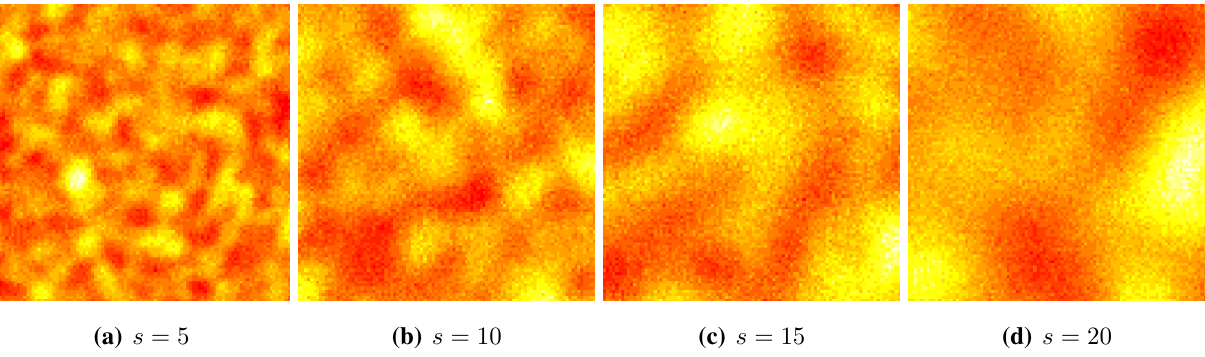
Figure 2. Gaussian random